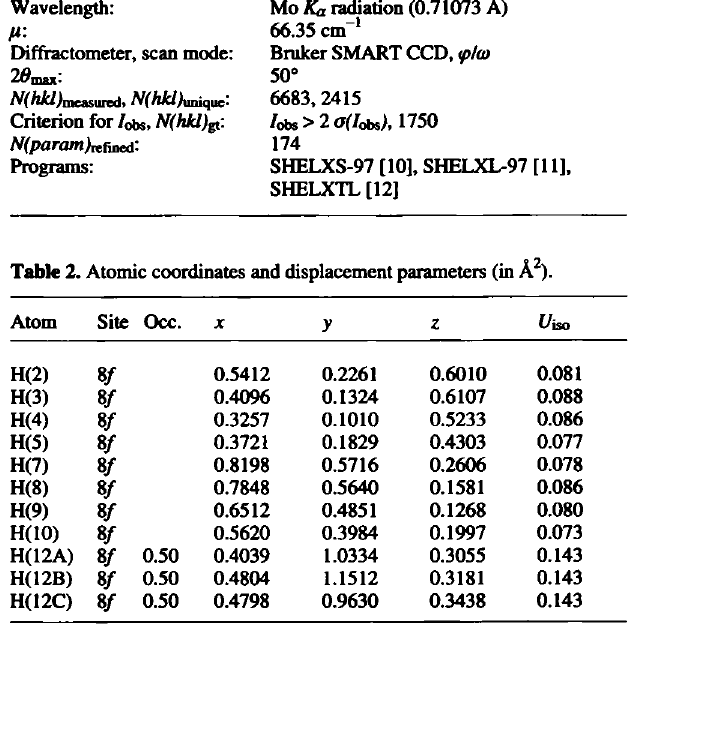
Table 1. Data collection and handling.